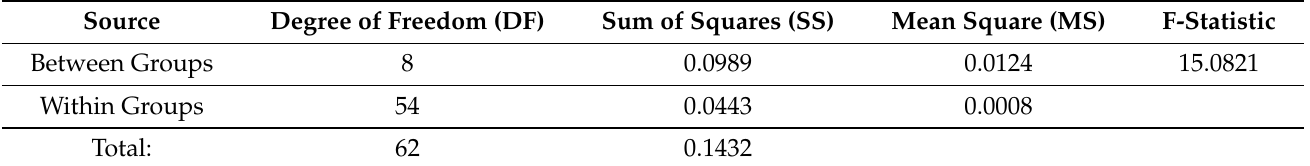
Table 13. The ANOVA results of different